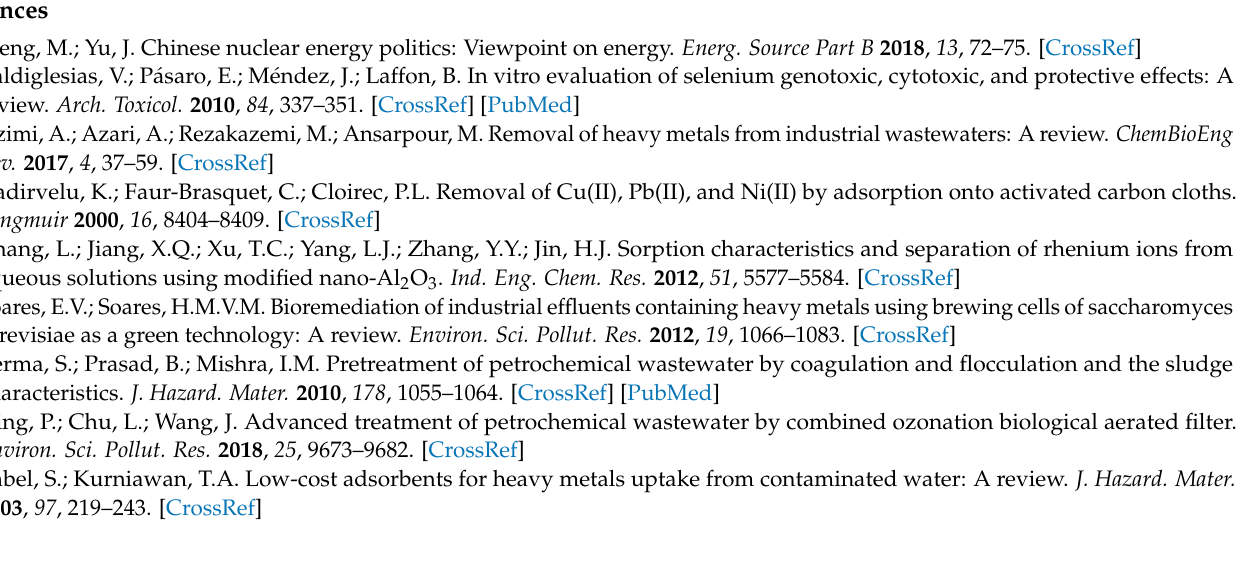
adsorbent. Figure S3: Exhibits N 2 adsorption–desorption isotherms of the 8%Fe 3 O 4 @MAC adsorbent. Figure S4: Displays pore size distributions of the 8%Fe 3 O 4 @MAC adsorbent. Figure S5: Exhibits the Table S1: Shows the parameters of adsorption kinetic and intraparticle diffusion